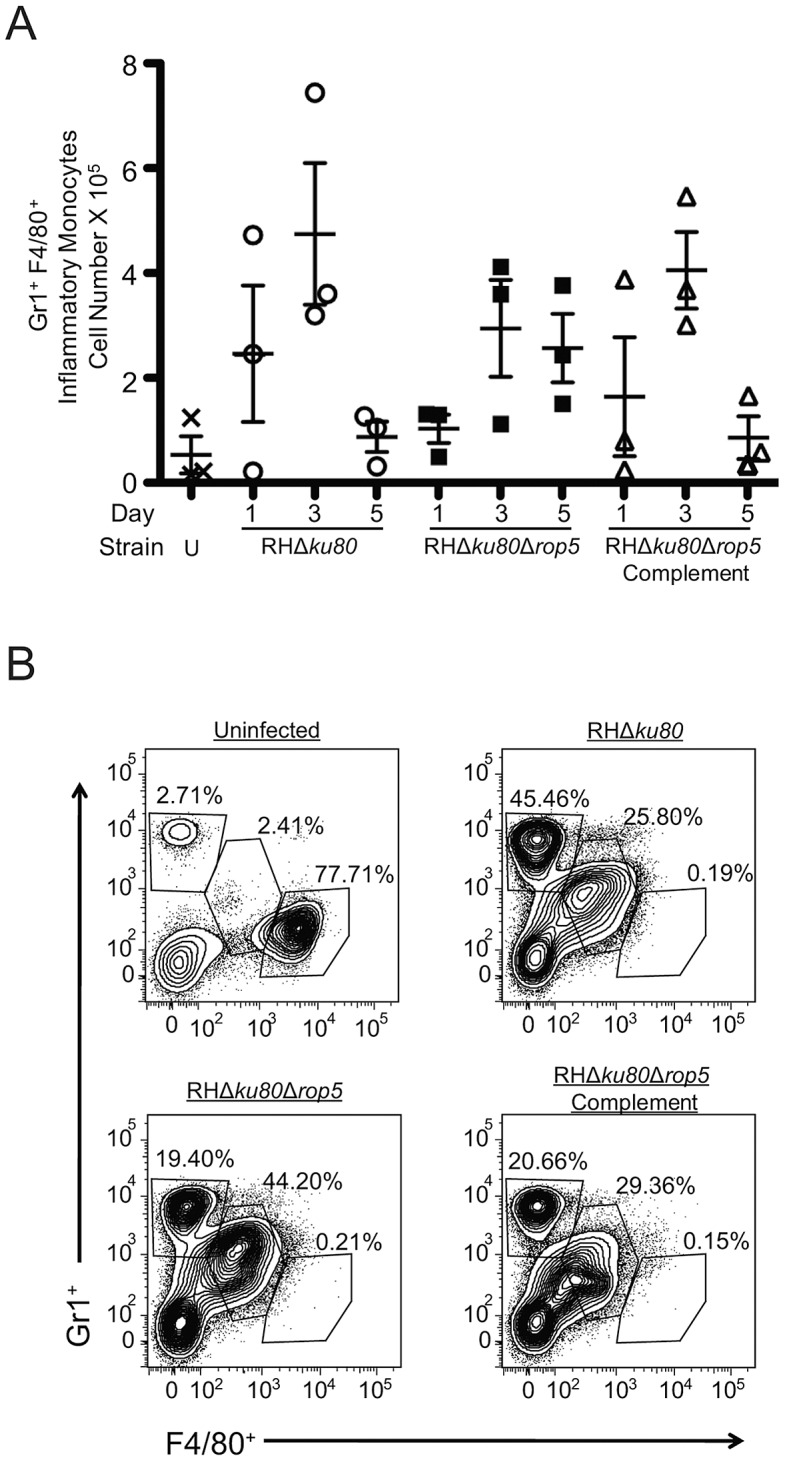
Gr1+ F4/80+ inflammatory monocytes are recruited to the peritoneum after infection with wild type or ROP5 deficient parasites.(A) CD-1 mice were infected with 103 wild type (RHΔku80), ROP5 deficient (RHΔku80Δrop5), or ROP5 complemented (RHΔku80Δrop5Complement) parasites and the number of Gr1+ F4/80+ cells was determined by cell surface staining and FACS. Mean ± S.E.M., n = 3 animals per group. (B) FACS plots of Gr1 and F4/80 gated cells from representative animals at day 3 postinfection in (A). Top left gate represents neutrophils (Gr1+ F4/80−), middle gate represents inflammatory monocytes (Gr1+ F4/80+), bottom right gate represents resident macrophages (Gr1− F4/80+). Data are derived from a single experiment, n = 3 mice/group. Plots for representative animals are shown.